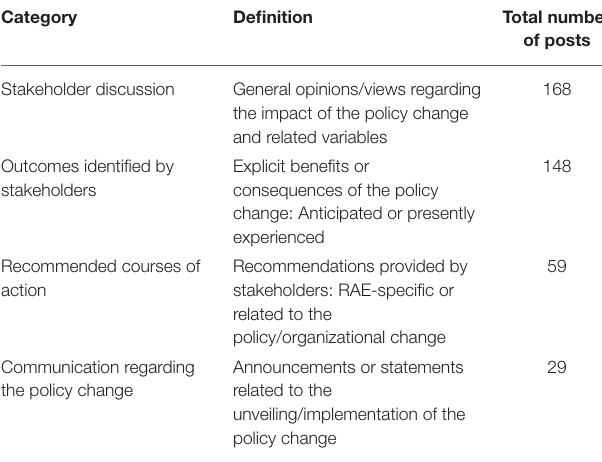
TABLE 1 | Outline of study